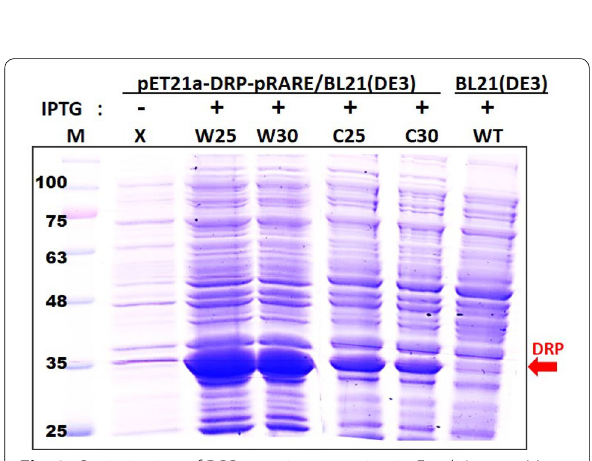
Fig. 3 Optimization of DRP protein expression in E. coli . Lane 1: M, lane 2: non‑induction by IPTG, lane 3 to 7 are with 0.1 mM IPTG. M, X, W25, W30, C25, C30, and WT mean marker, whole cell which cultured at 25 °C, whole cell which cultured at 30 °C, crude enzyme which cultured at 25 °C, crude enzyme which cultured at 30 °C, and wild type of BL21(DE3). DRP has indicated by red